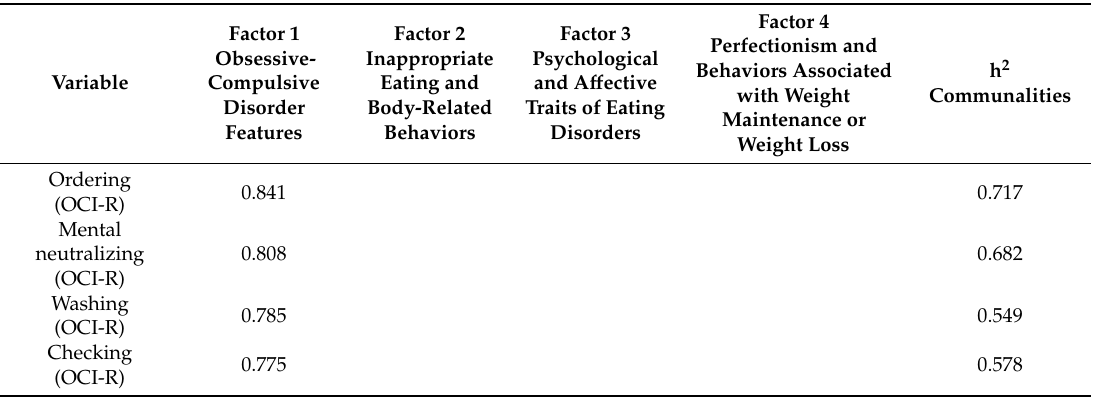
Table 2. Exploratory factor analysis of the scales scores using the promax